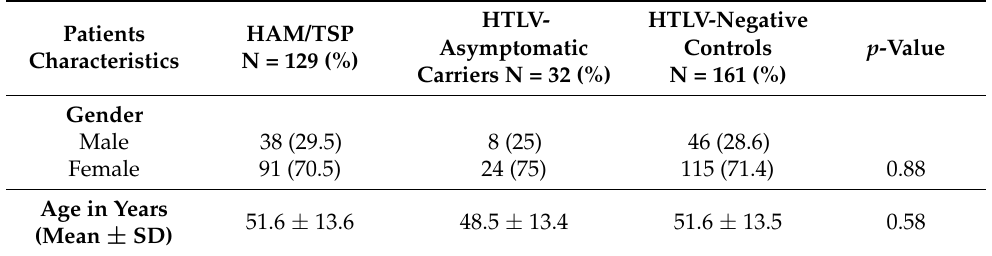
Table 1. Demographic characteristics of patients infected by HTLV and HTLV-negative controls. Patients